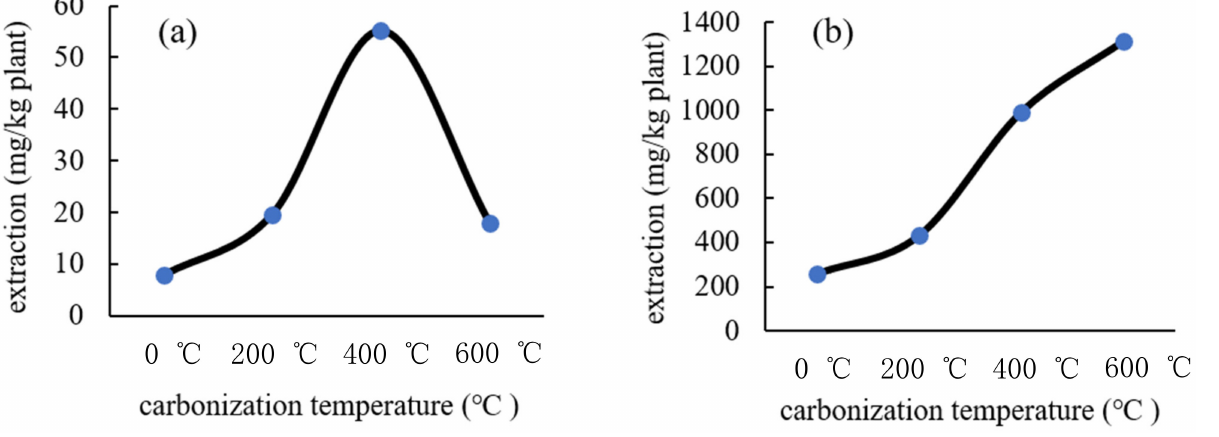
Figure 13. Effect of the carbonization temperature on the extraction of ( a ) Cd and ( b ) Zn from the incineration ash of